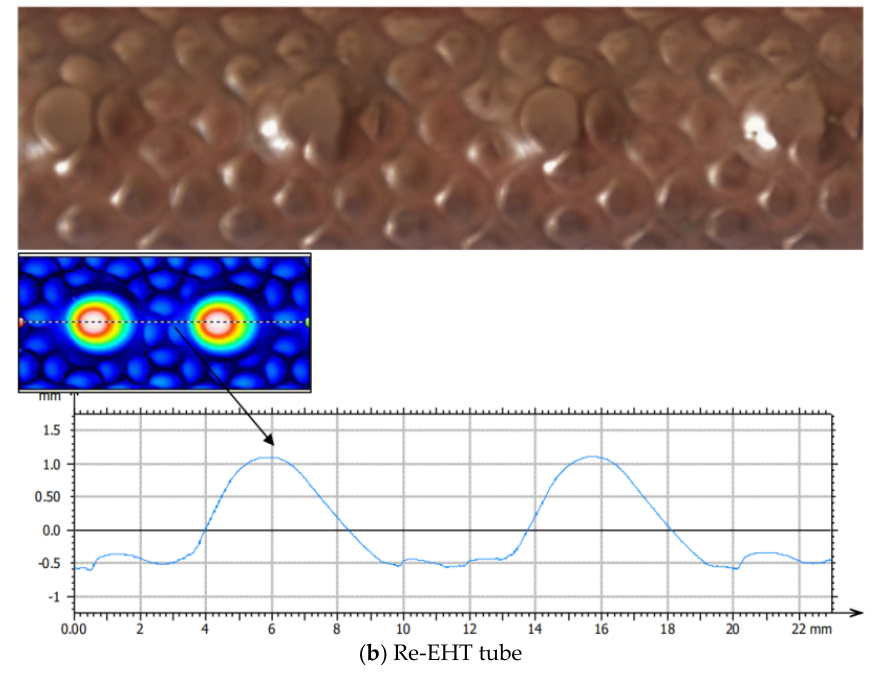
Figure 1. The external surface structure of the ( a ) EHT tube and ( b ) Re-EHT tube. Table 3. Details of the test tubes.